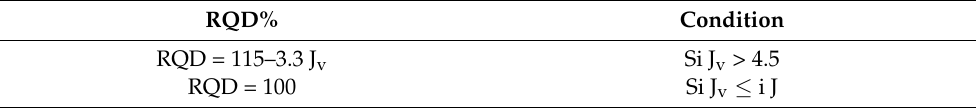
Table 2. Correlation between RQD and volumetric discontinuity according to Palmstrom